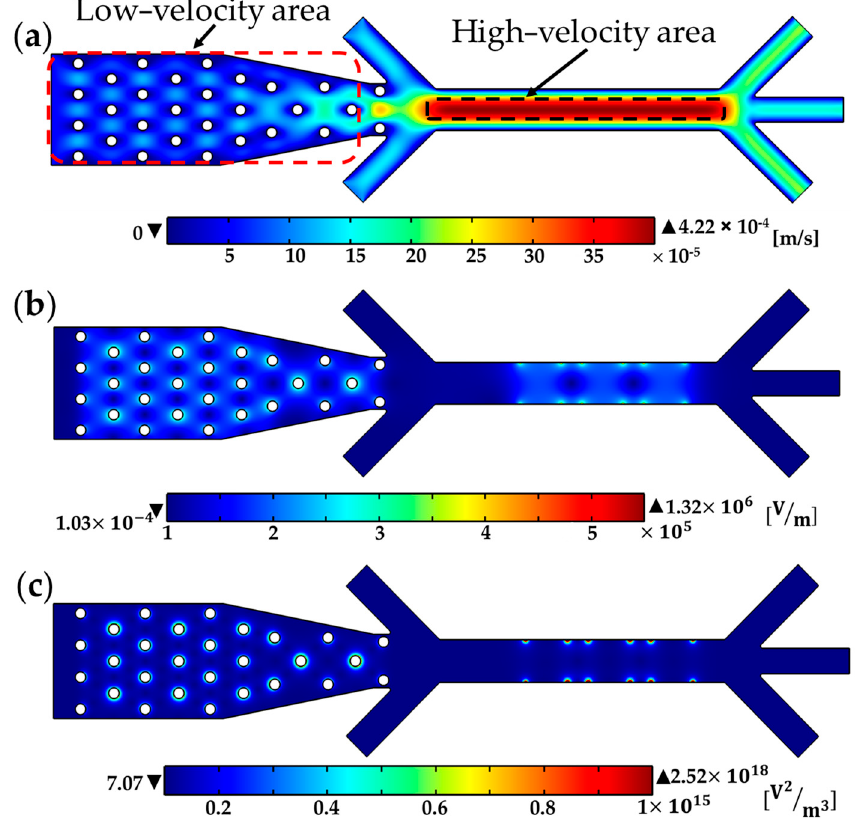
Figure 5. ( a ) Velocity field in the microchannel; ( b ) Electric field distribution in the microchannel; ( c ) Electric field gradient distribution in the microchannel.